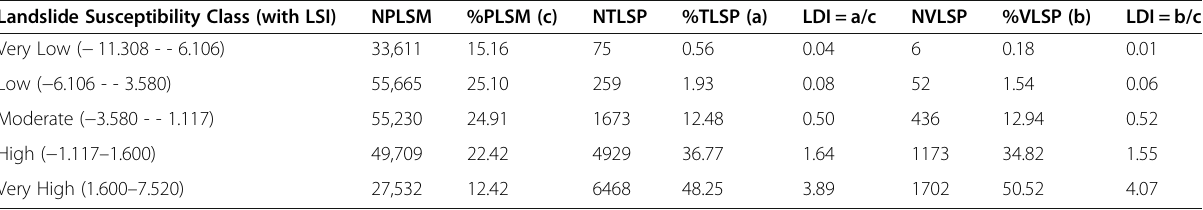
Table 3 Validation of the model using landslide density index (LDI) Landslide Susceptibility Class (with LSI)